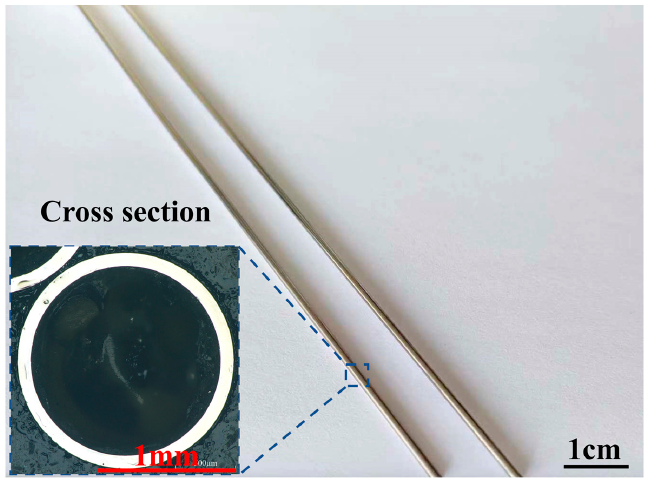
Figure 7. Ultra-slender cobalt–chromium alloy cardiovascular stent tubes. Table 3. Composition of Co–Cr cardiovascular stent tubes.